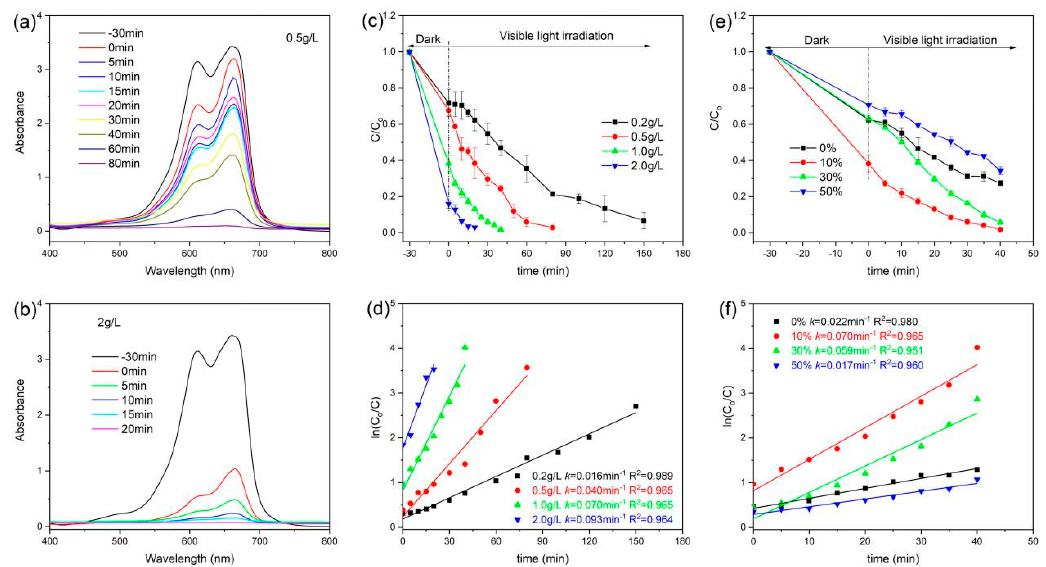
Figure 8. ( a,b ) UV–vis absorption spectra of MB dye degradation by RGO/BiOCl/TiO 2 -10% nanocomposites under visible light irradiation; ( c ) photodegradation efficiency of MB dye under various nanocomposite concentrations; ( d ) the corresponding fit curves obtained by pseudo-first- order kinetic model; ( e ) photodegradation efficiency of MB dye under the nanocomposites with various TiO 2 contents (the nanocomposite concentration: 1.0 g/L); and ( f ) the corresponding fit